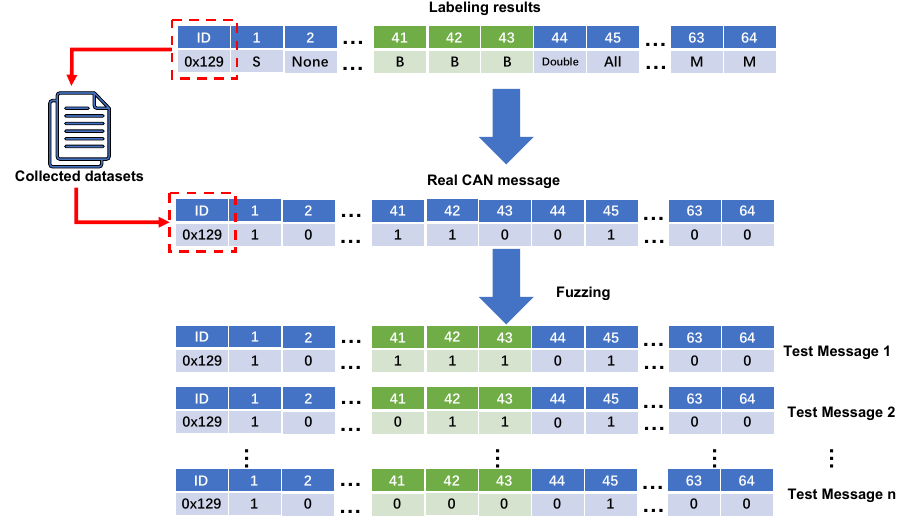
Figure 6. Test message generation